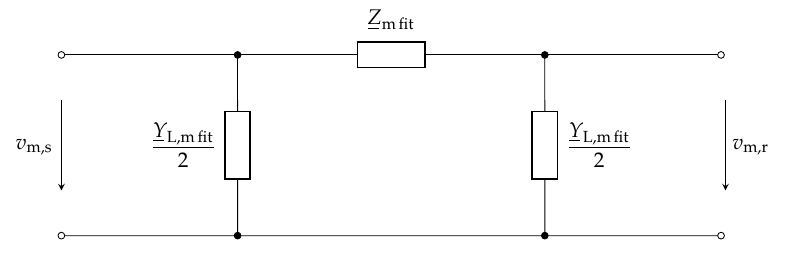
Figure 2. PI-section with the frequency